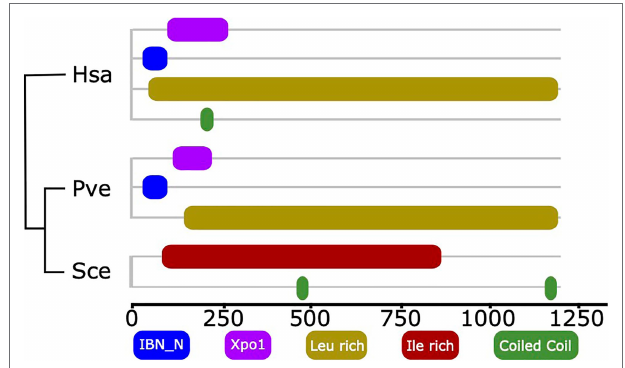
FIGURE 4 | Domain architecture comparison of Xpo5 between human and fungal orthologs. The two Pfam domains linked to import/export activity of human Xpo5, IBN_N (Pfam ID: PF03810) and Xpo1 (Pfam ID: PF08389) are still present in an early branching fungus and were secondarily lost in yeast. The phylogenetic relationships of the three taxa are indicated by the tree. Hsa, Homo sapiens ; Pve, Podila verticillata (Mucoromycota); and Sce, Saccharomyces cerevisiae